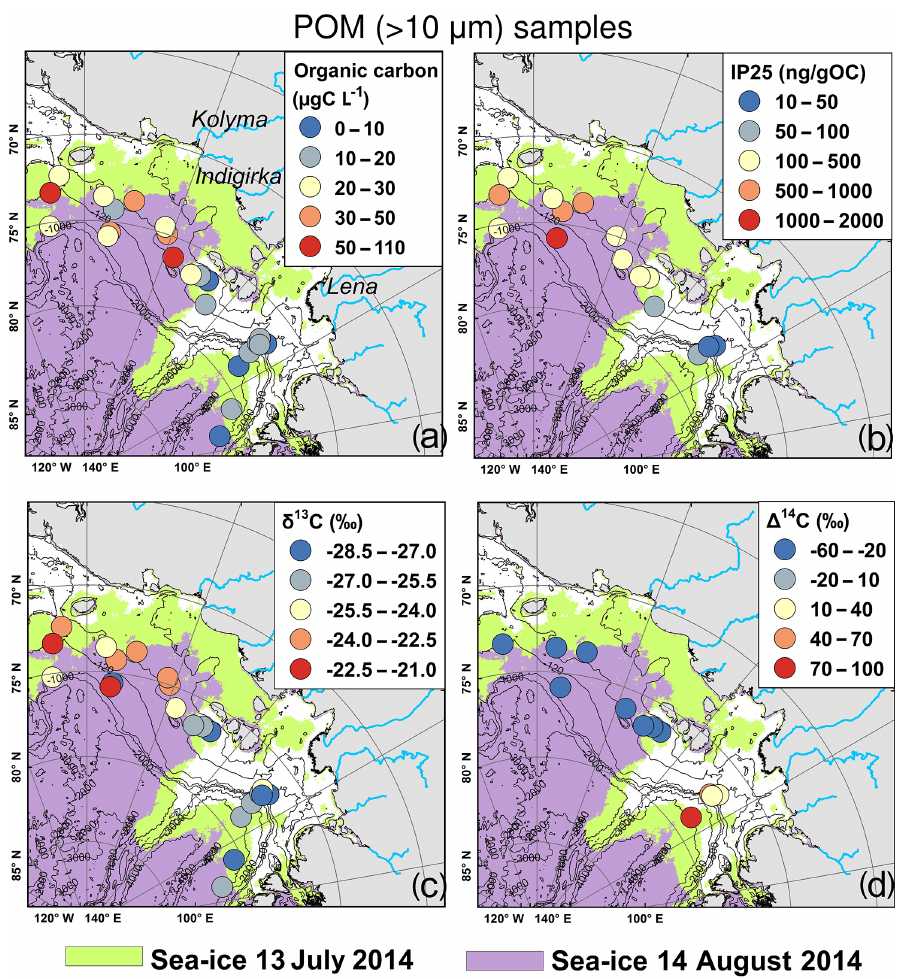
Figure 4. POM (>10µm) composition. (a) Organic carbon concentration. (b) IP25 (monounsaturated highly branched isoprenoid. (c) δ 13 C. (d) (cid:49) 14 C. Shaded areas show the sea ice extent at the beginning (13 July 2014) and at the end of the sampling campaign (14 August 2014).